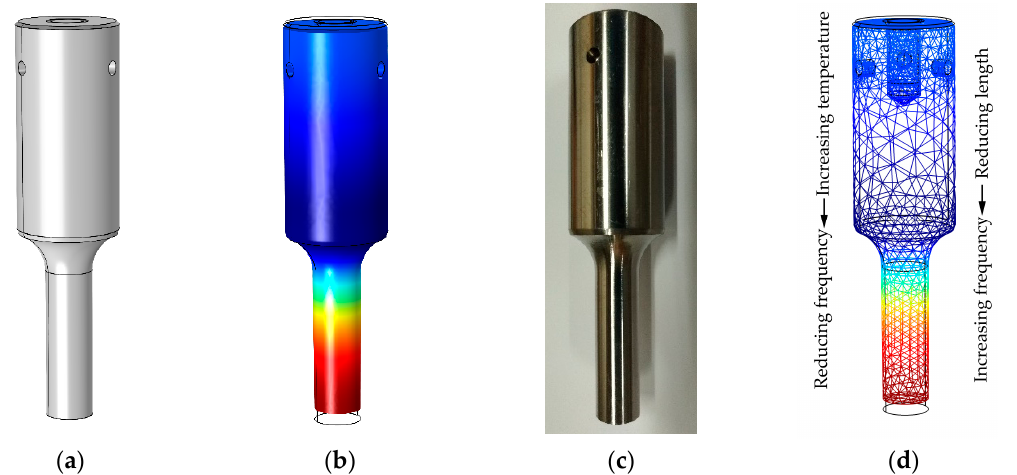
Figure 6. Optimization of the sonotrode for high temperature. ( a ) Sketching the main design. ( b ) Solving the model for a normal temperature and for a high temperature by changing the length after introducing the dependent properties on temperature (explained up); ( c ) manufacturing the sonotrode with some length tolerance for experimental analysis, taking into account that ( d ) the eigenfrequency at the wanted eigenmode (longitudinal vibration mode in the present study) can be reduced when the temperature increases and can be increased by reducing the length of the sonotrode. The attenuation factor inside the melt should be considered as well.